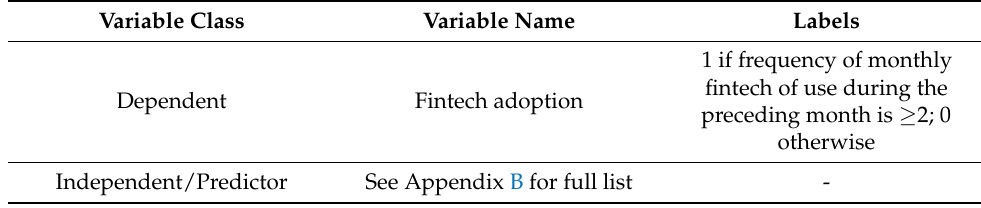
Table 1. Dependent and Independent Variables for Multivariate Logistic Regression.